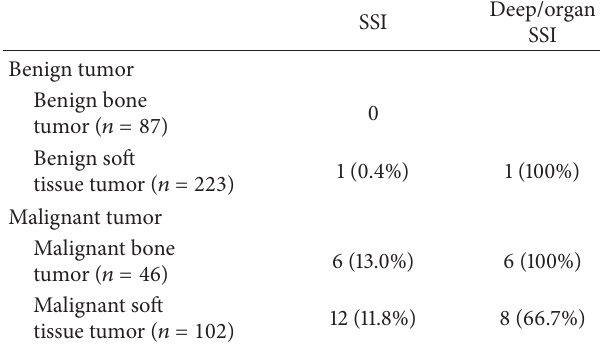
Table 1: Incidence of SSI by tumor